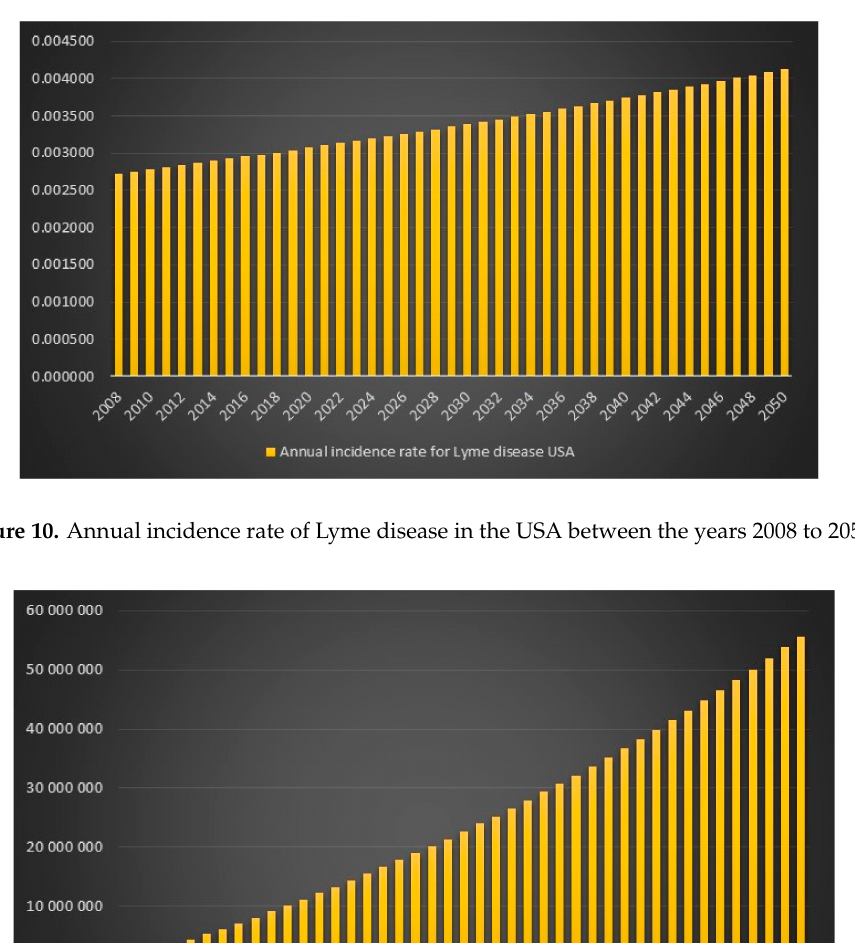
Figure 9. Number of Lyme disease infections in the USA between the years 2008 to 2050.